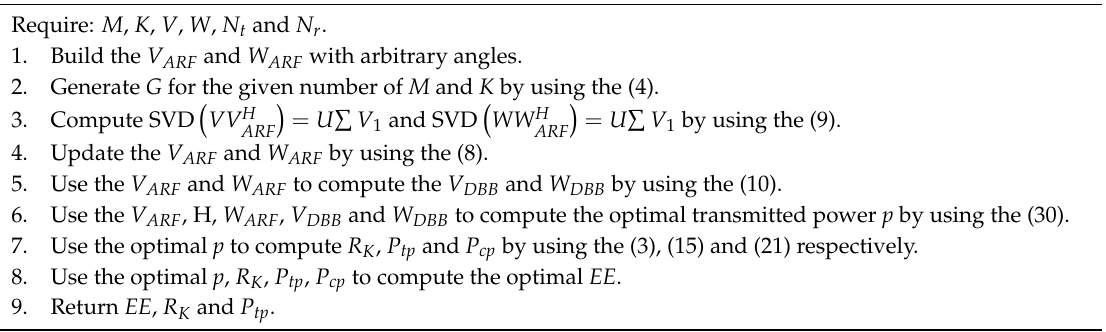
Algorithm 1 Power Controlled Energy Maximization (PCEM)